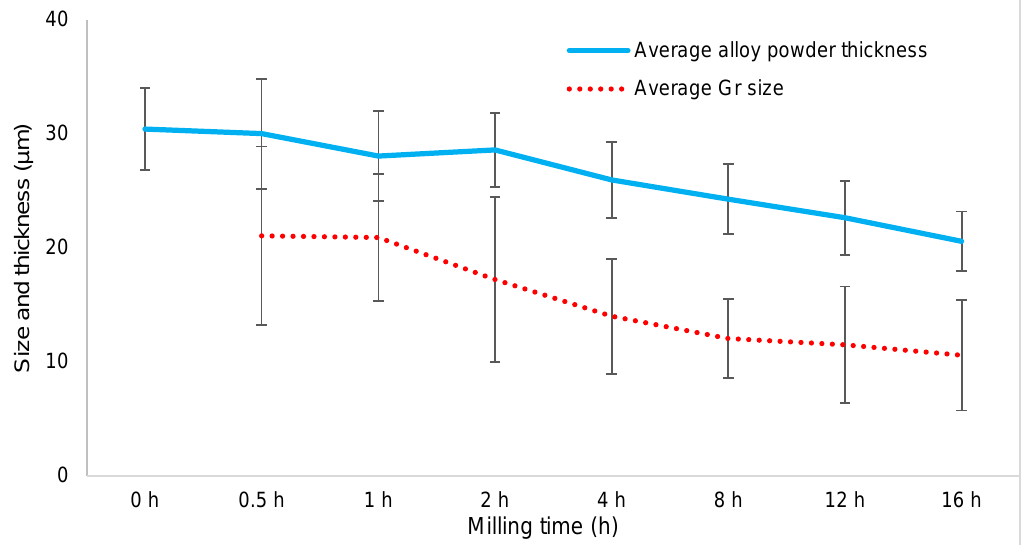
Figure 9. Average particle thickness of the as-received and milled composite powder.